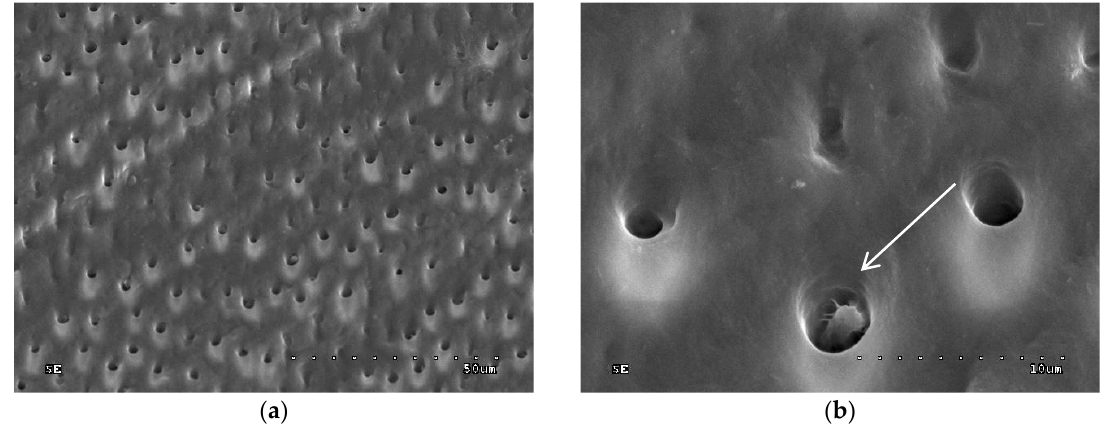
Figure 6. SEM image of dentine surface after application of 0.2% CHG for 30 s and acid etching—group 7: ( a ) 1000×; ( b ) 5000×. Arrow indicates peritubular dentine residues.